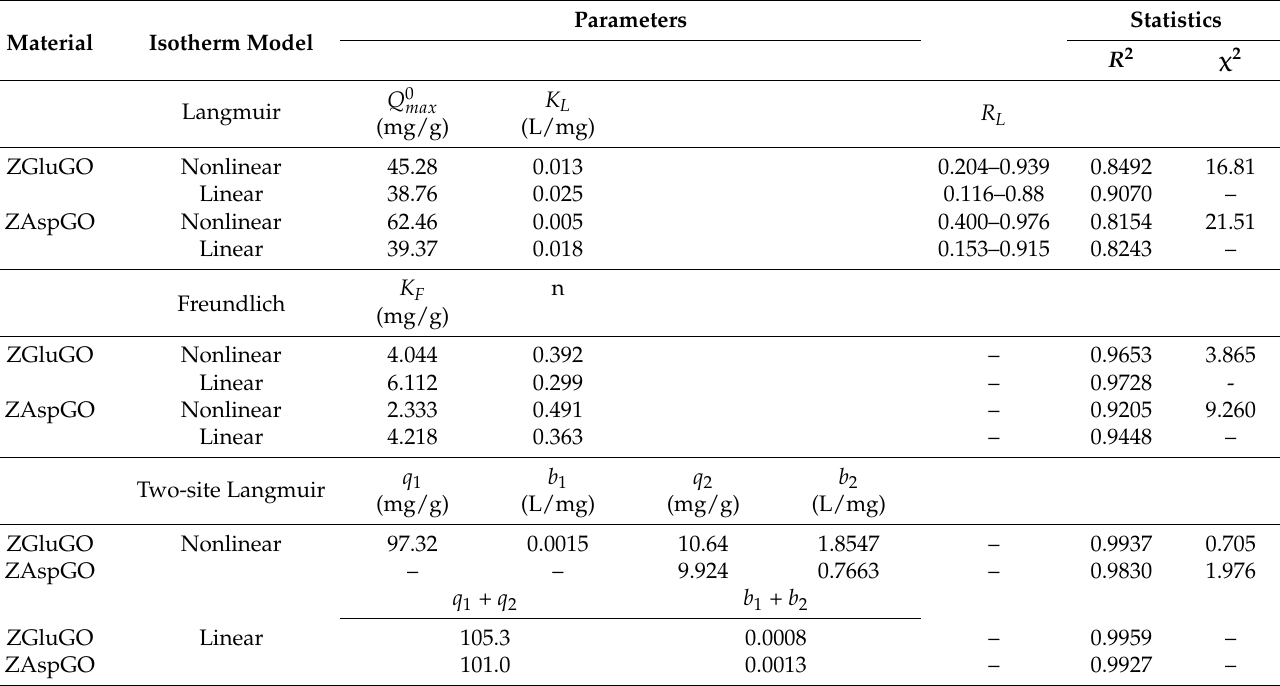
Table 2. Calculated parameters for fluoride-adsorption isotherm models of ZGluGO and